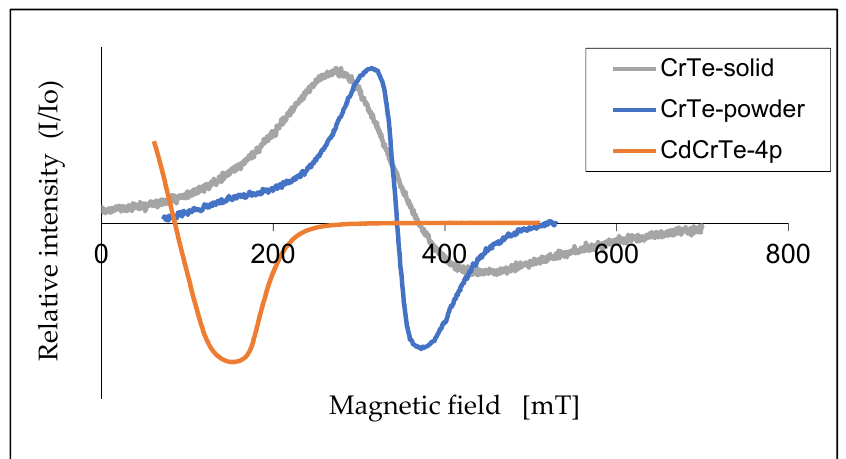
Figure 11. EPR spectra of powered, solid Cr 2 Te 3 , and the sample 4p (T ≈ 260 K).